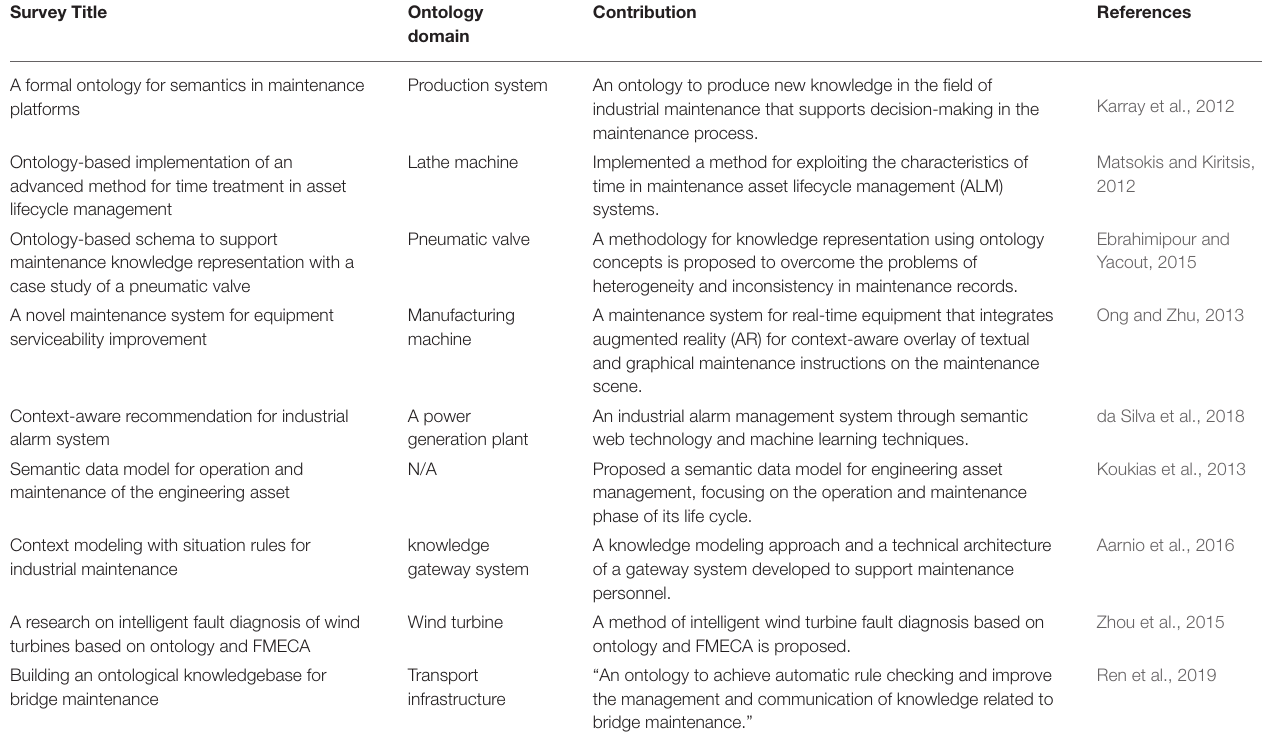
TABLE 5 | Summary of ontologies in maintenance and asset